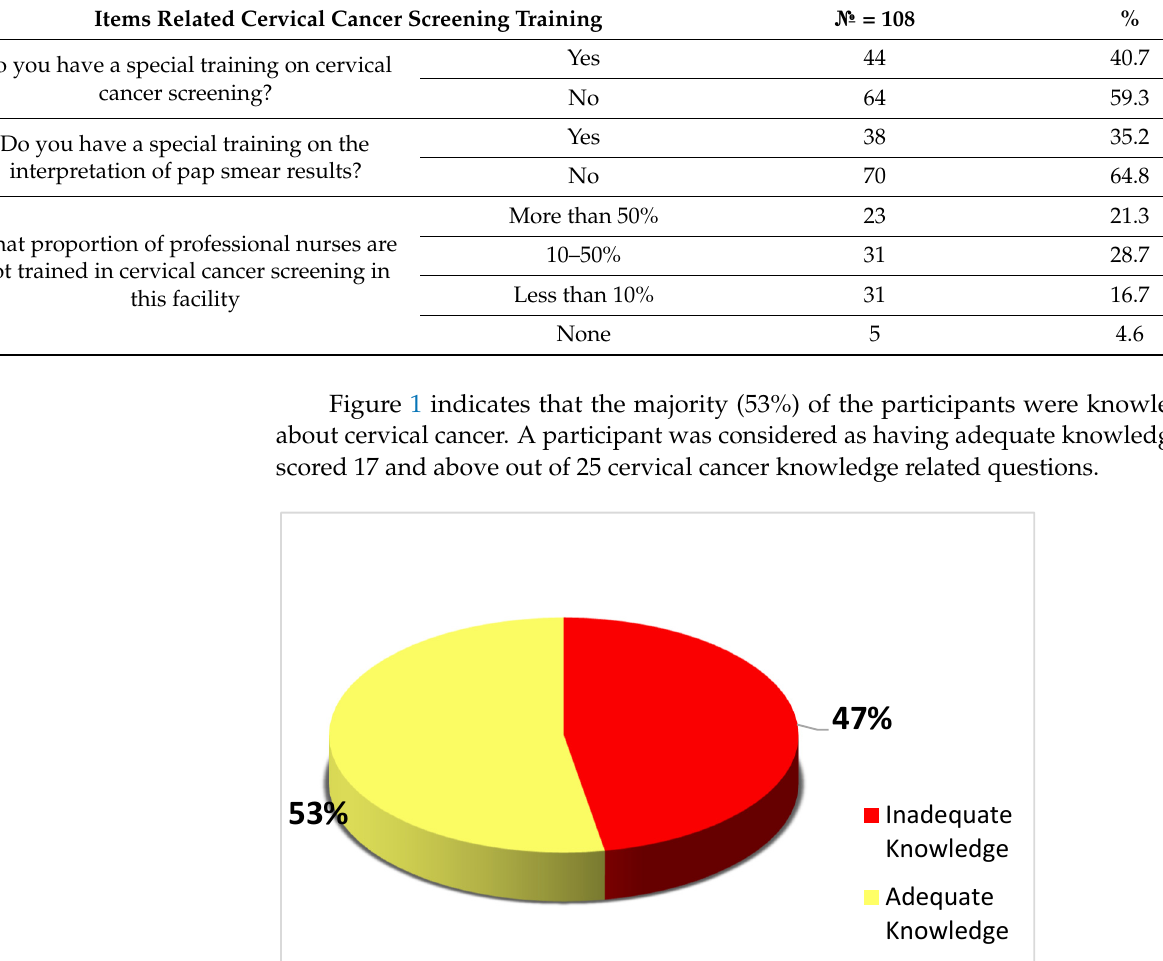
Table 3. Cervical cancer screening training among participants.